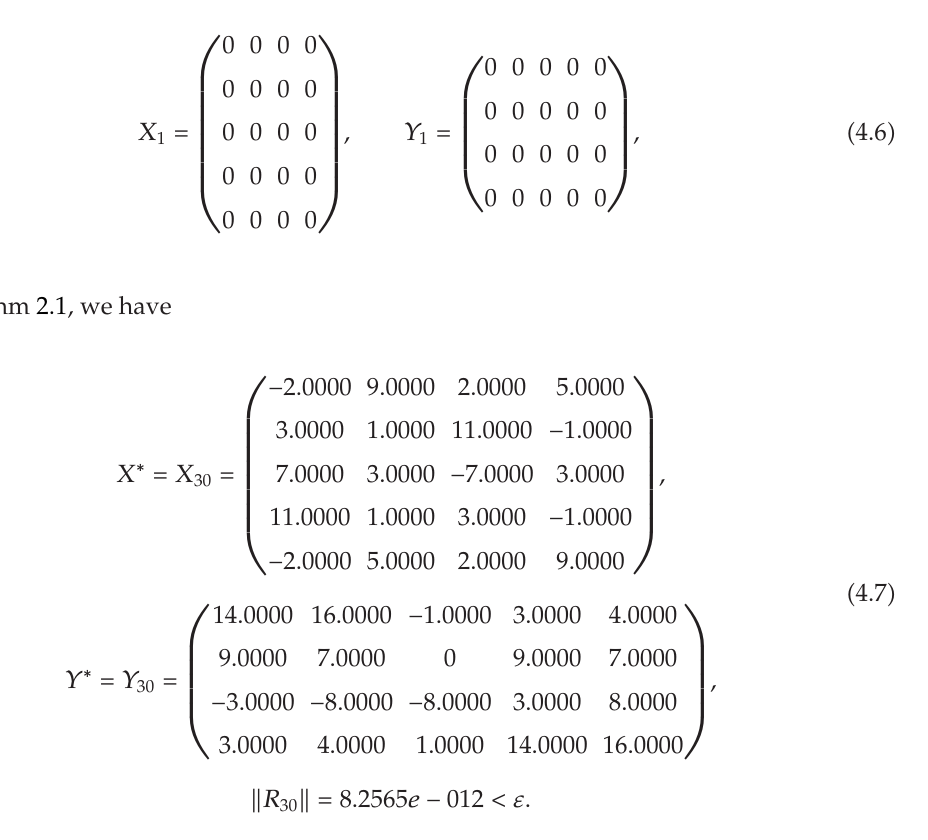
Figure 1, where the relative error REk (cid:4) (cid:2) (cid:6) X k − X ∗ (cid:6) (cid:8) (cid:6) Y k − Y ∗ (cid:6) (cid:3) / (cid:2) (cid:6) X ∗ (cid:6) (cid:8) (cid:6) Y ∗ (cid:6) (cid:3) and the residual Rk (cid:4) (cid:6) R k (cid:6)